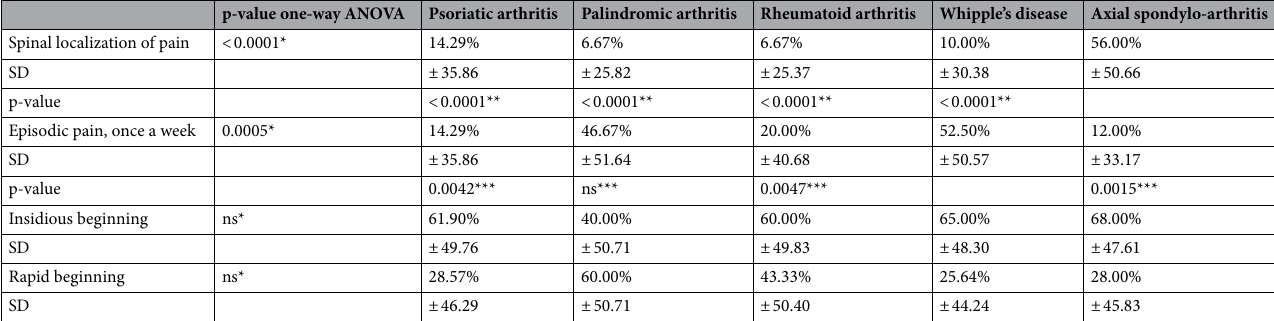
Table 3. Frequency of spinal localization and episodic character of pain in 40 patients with Whipple’s disease compared to palindromic-, rheumatoid -, psoriatic -, and axial spondyloarthritis. SD standard deviation. *One-way ANOVA. **One-way ANOVA followed by Holm–Sidak’s multiple comparison tests vs. axial spondyloarthritis patients. ***One-way ANOVA followed by Holm–Sidak’s multiple comparison tests vs. Whipple’s disease